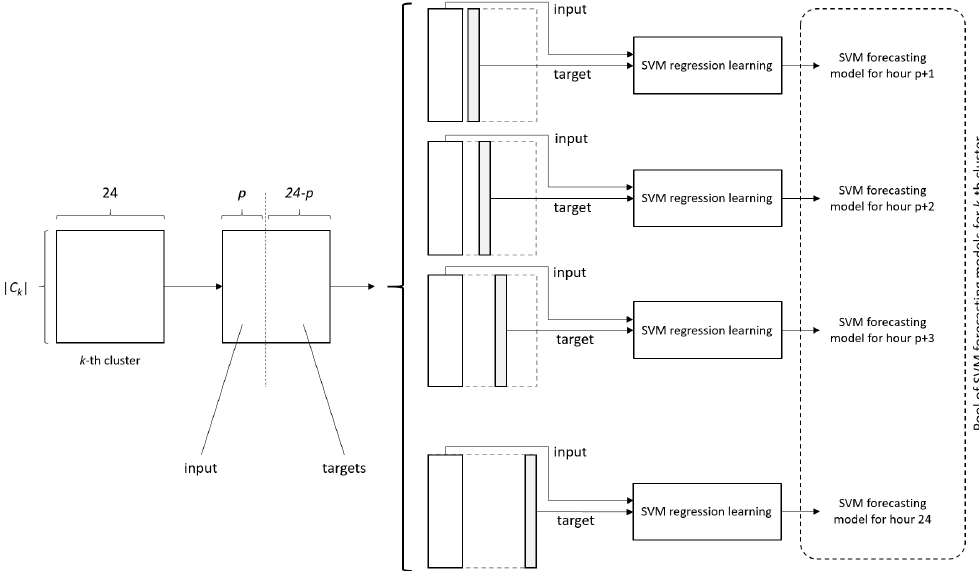
Figure 3. A schematic representation of the second stage of the approach: learning a pool of Support Vector Machine (SVM)-based regression models for each cluster to predict hourly water demand.